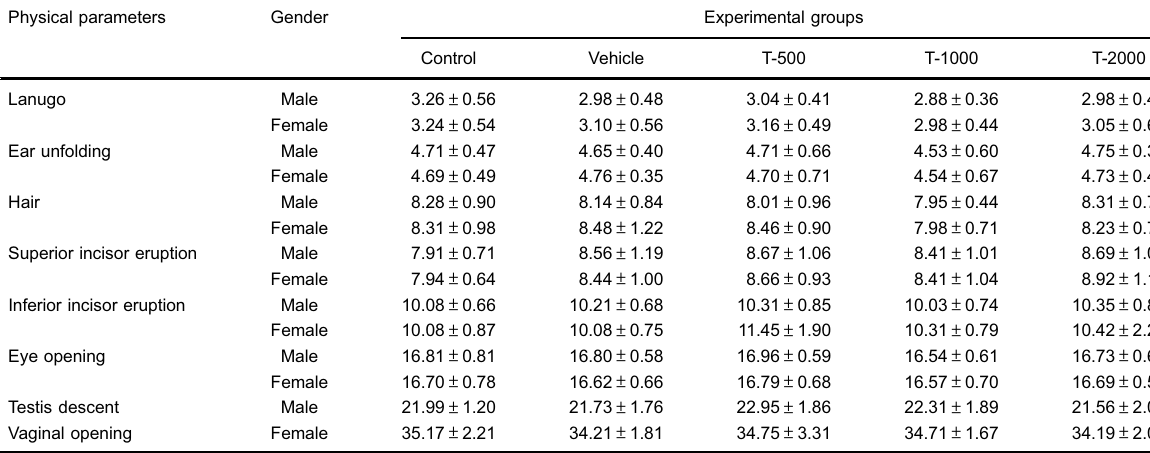
Table 2. Day of appearance of the physical development signs analyzed in the groups. Physical parameters